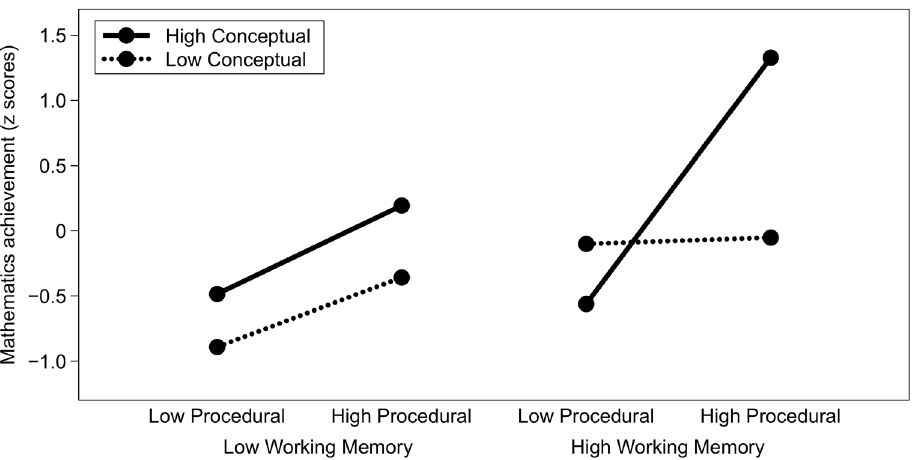
Figure 2. Predicted mathematics achievement (WIAT mathematics composite z scores) for high (1 SD above mean) and low (1 SD below mean) levels of procedural skill, conceptual understanding and working